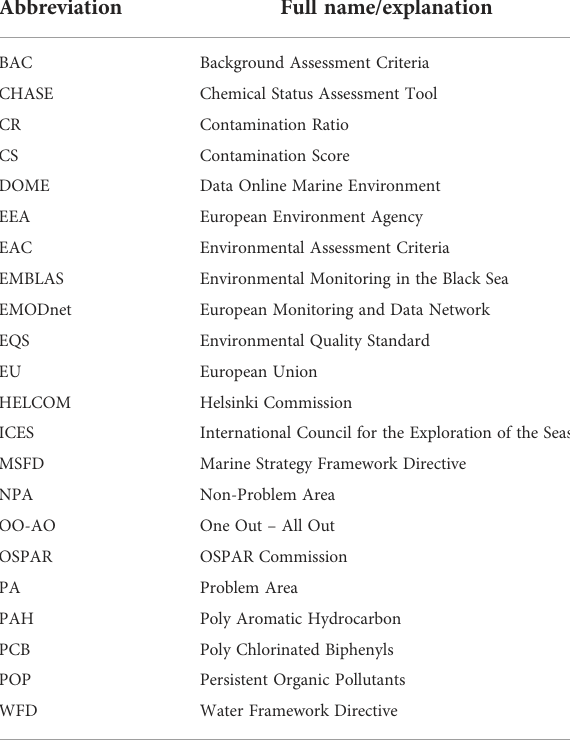
TABLE 1 List of abbreviations used in this